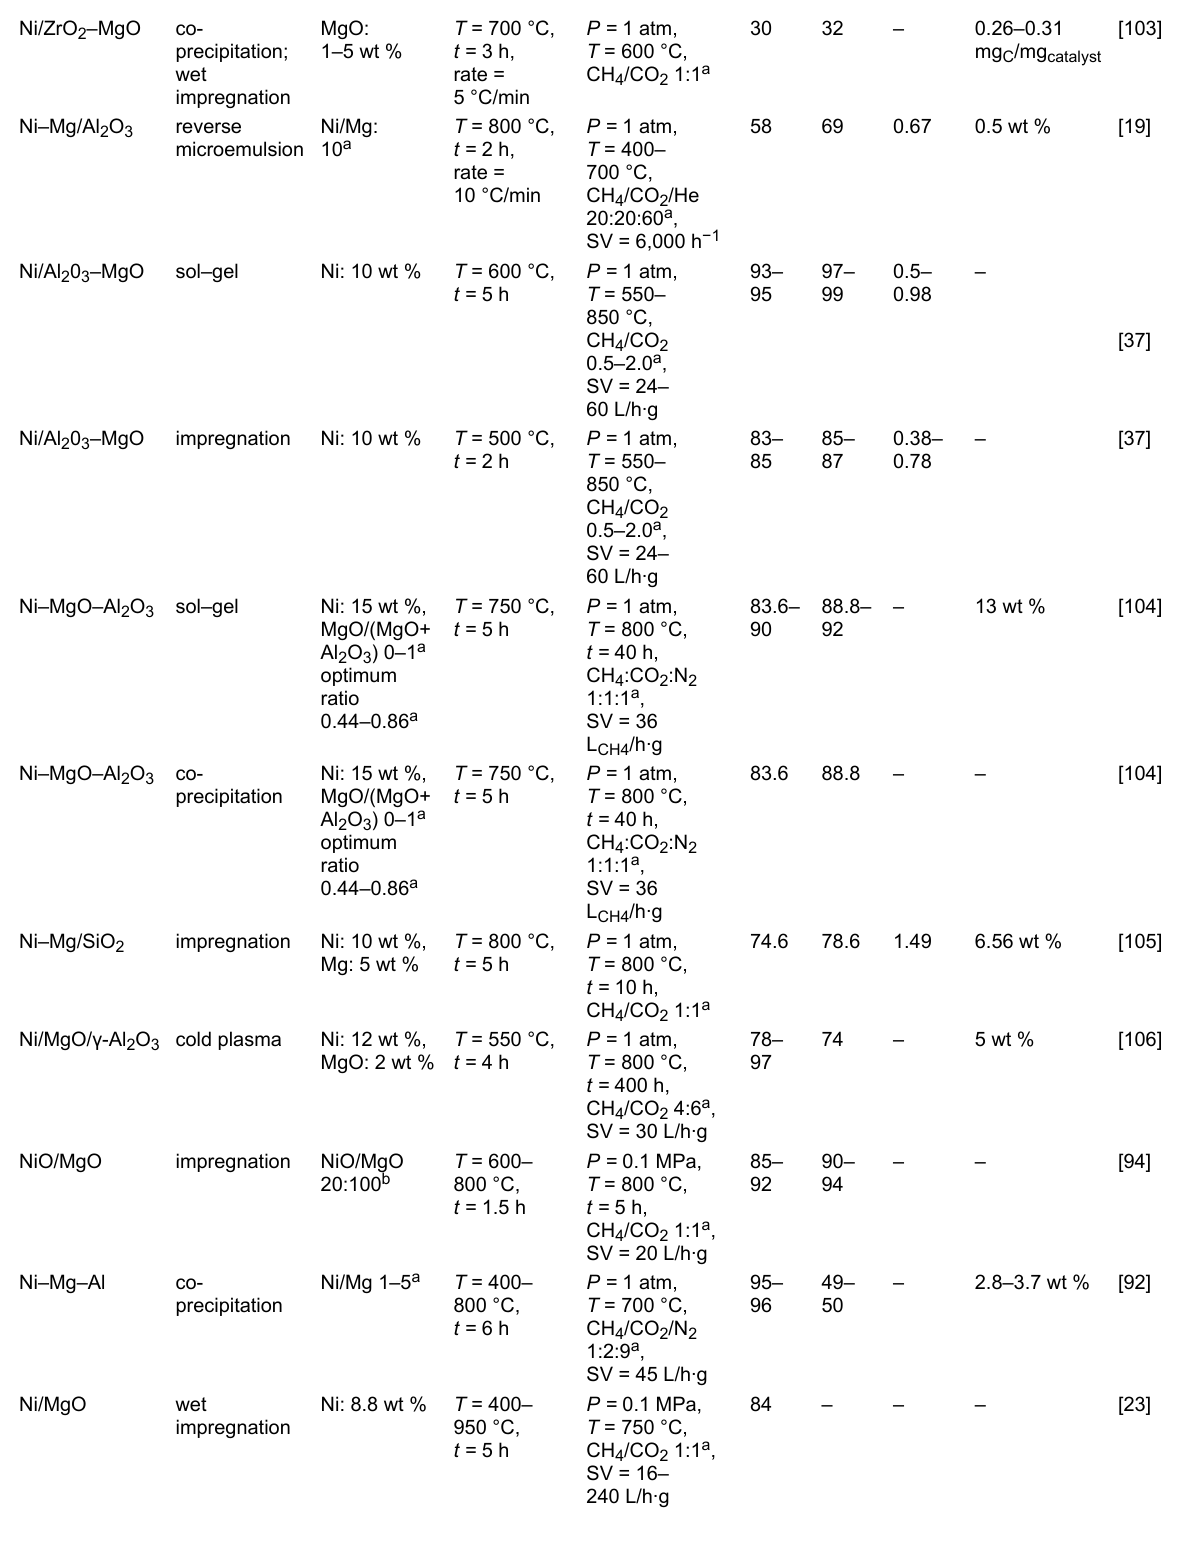
Table 3: Literature summary on the development and process conditions of Mg-containing oxide catalysts in DRM. PM: Preparation method; W: metal loading; CC: calcination conditions; RC: reaction conditions; SV: space velocity.